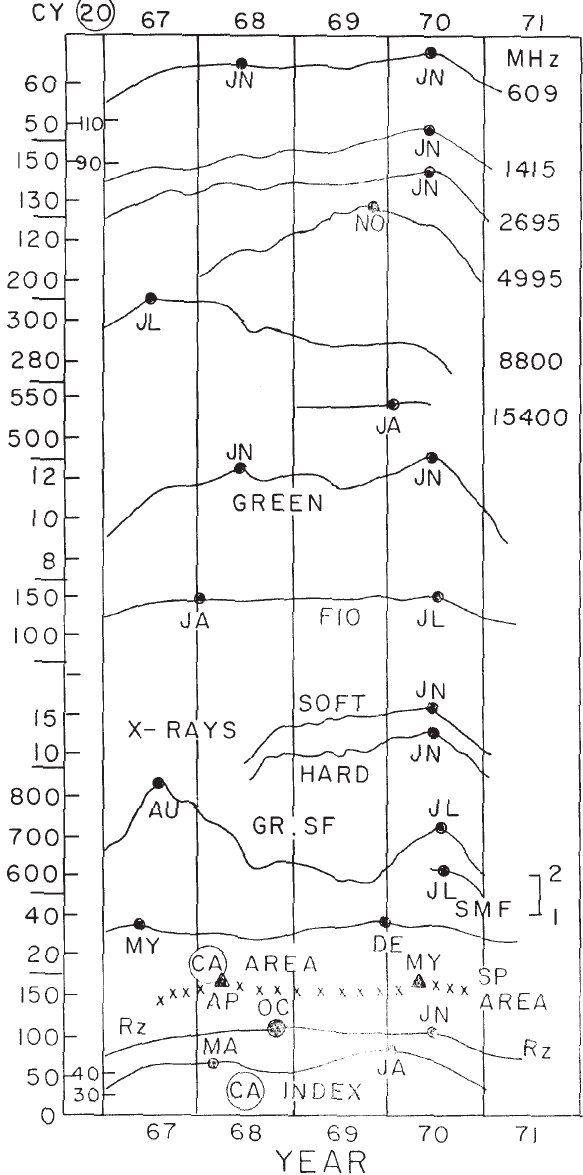
Fig. 4. Plots of smoothed values of the various solar indices in years near sunspot maximum of cycle 20, 1967–1971. The full dots indicate